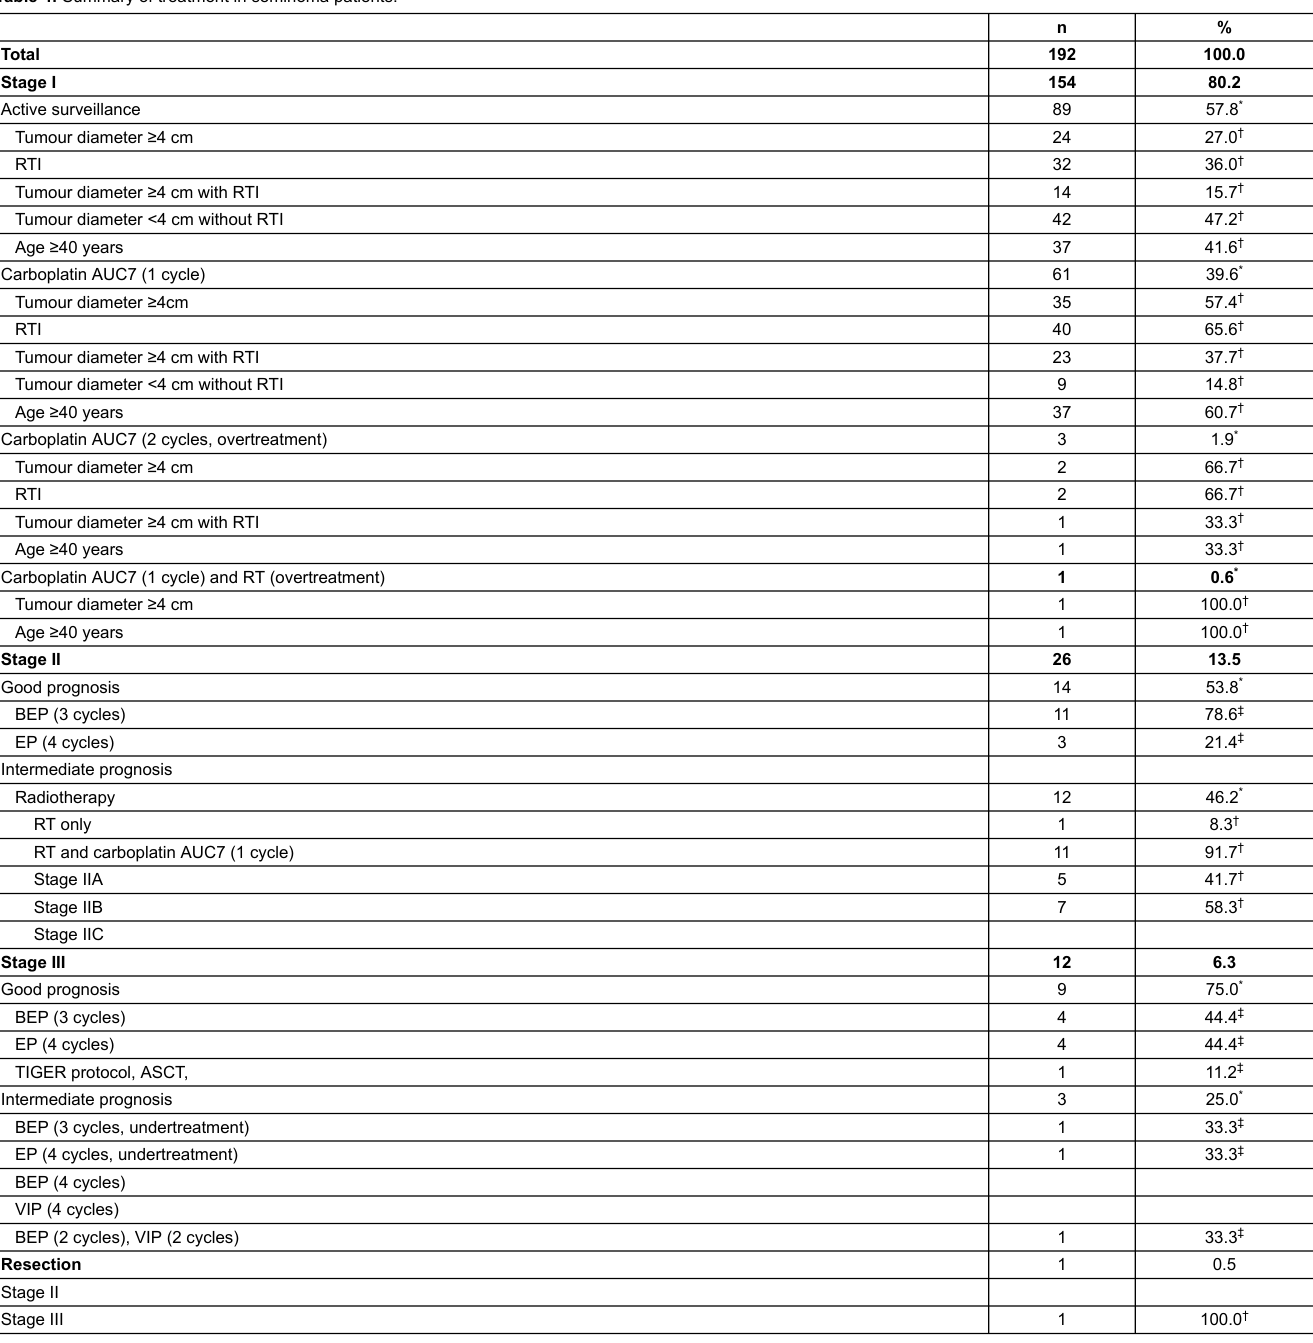
Table 4: Summary of treatment in seminoma